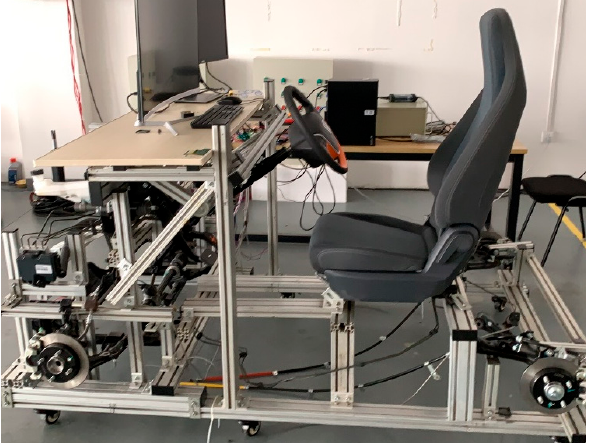
Figure 12. Hardware-in-the-loop test bench.